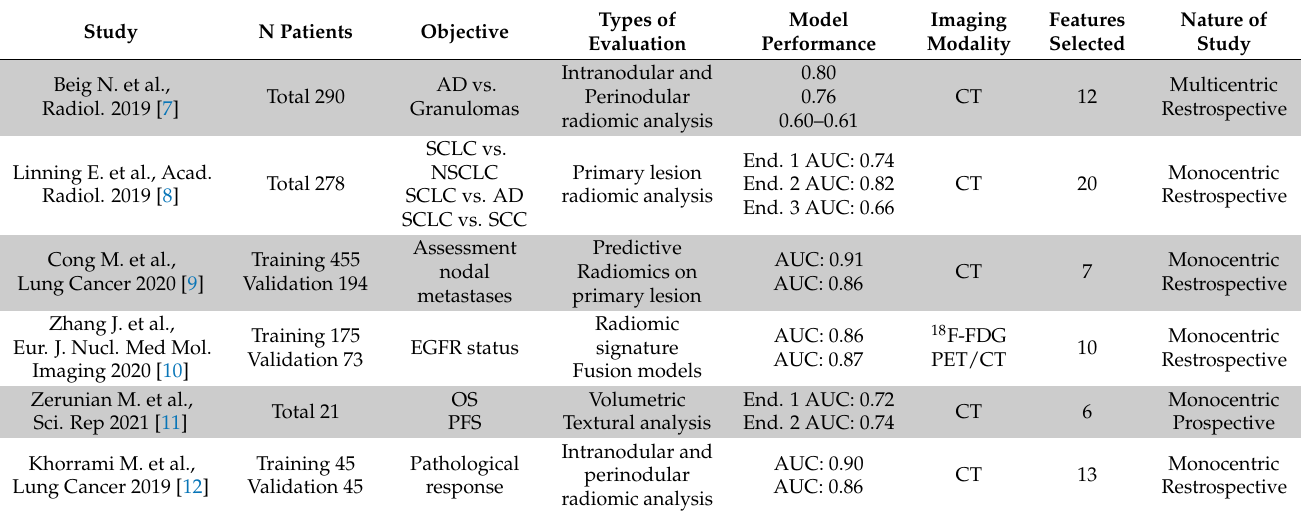
Table 1. Table summarizing the main studies of Radiomics applied to lung